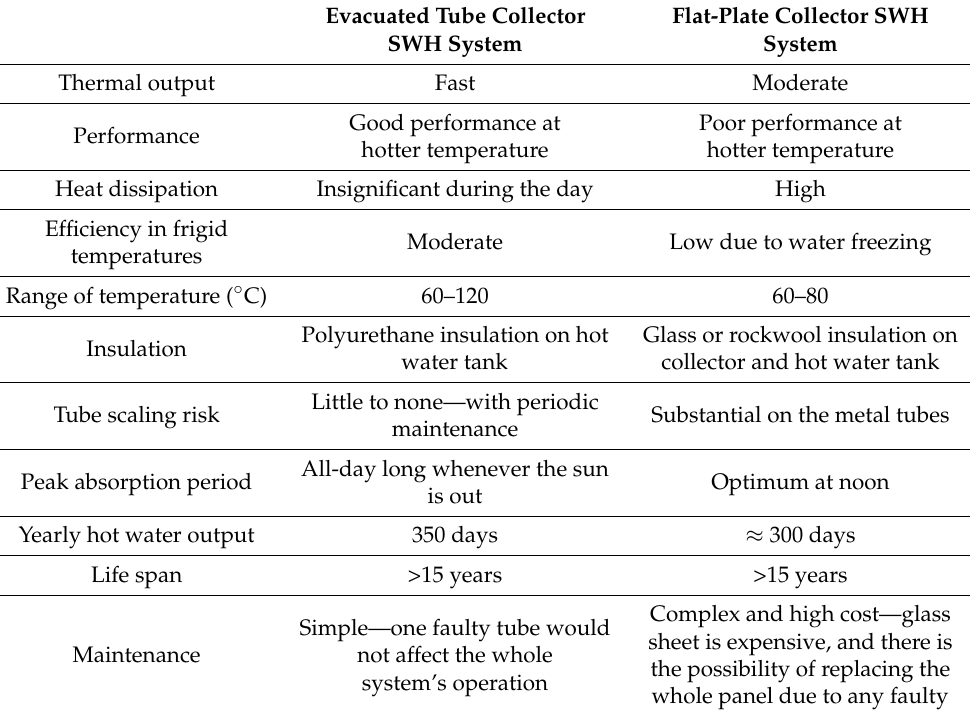
Figure 9. Summary of the different types of ETC-SWH systems. Table 4. Performance comparison of ETC- and FPC-SWH technologies. Adapted from Sunflower Solar